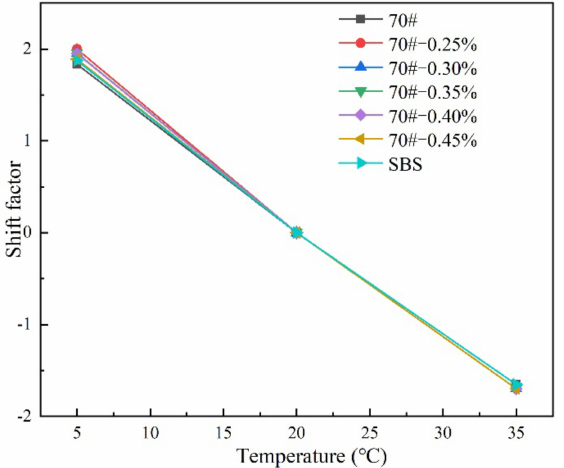
Figure 5. Shift factors for HMAB under different